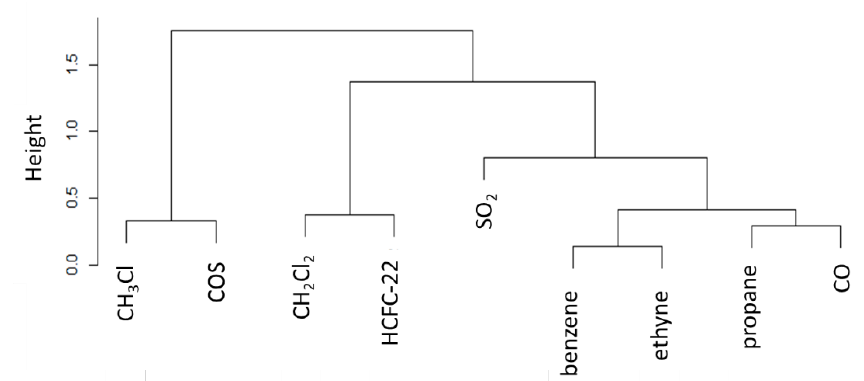
Figure 6. Dendrogram of cluster analysis of atmospheric trace gases for the smoothed dataset. Note that the y-axis denotes the cluster distance (indicated as “height”).